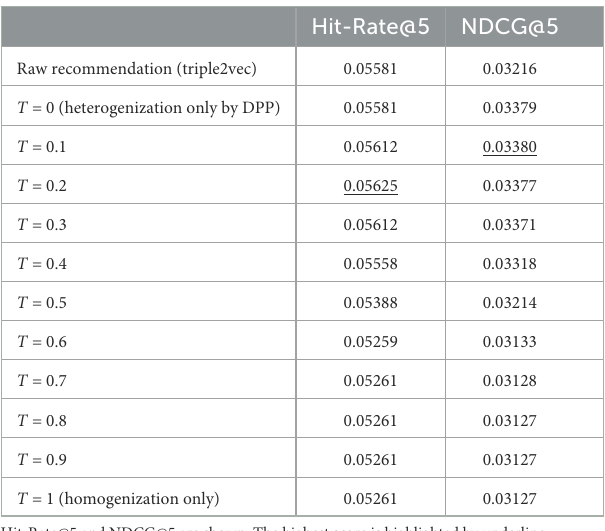
TABLE 1 Detailed results of next-item